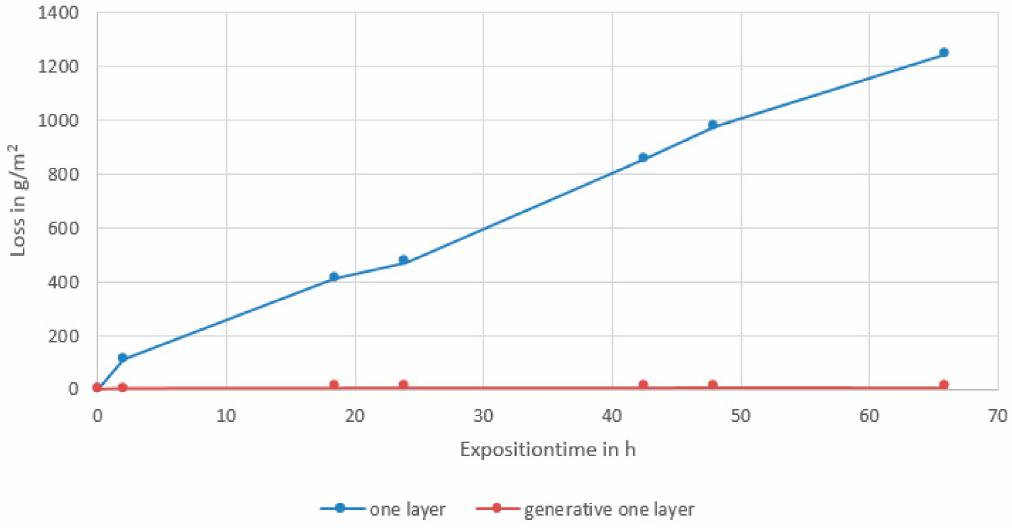
Figure 14. Material loss over exposure time.